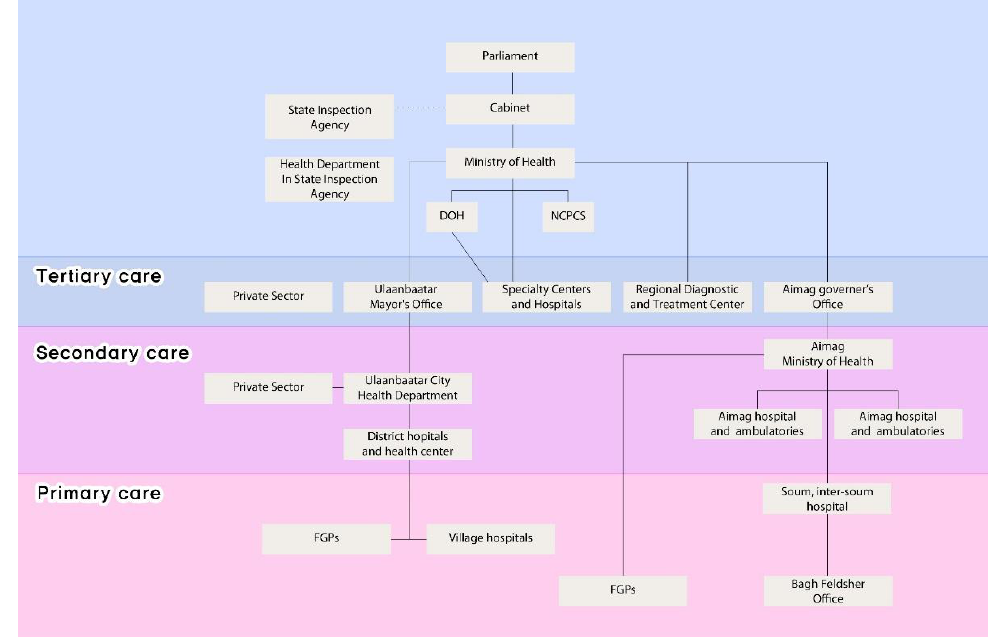
Figure 3. Mongolian health administration organization.